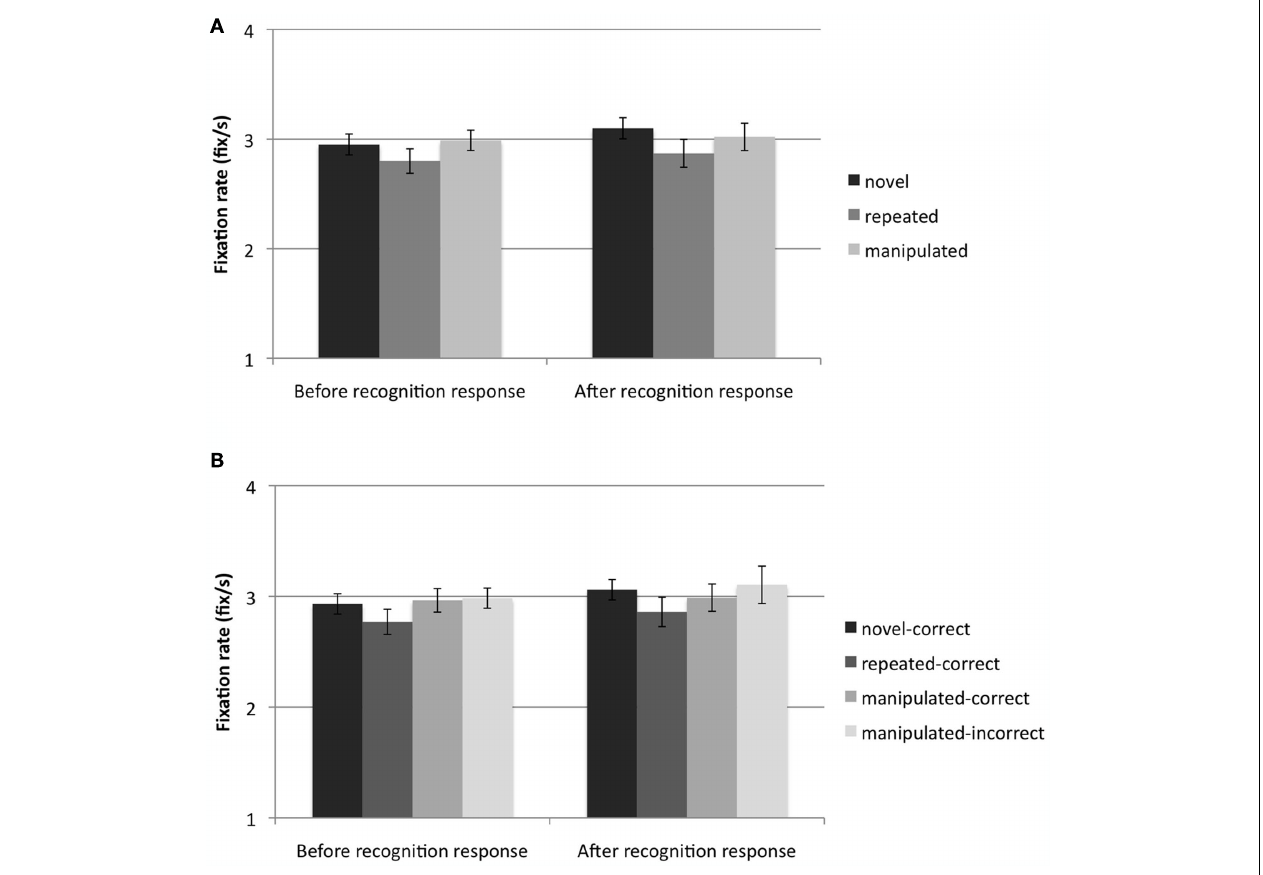
FIGURE 3 | Mean fixation rate (fixations per second) before and after participants’ recognition response across (A) face type: novel, repeated, and manipulated faces; and (B) response type: novel-correct, repeated-correct, manipulated-correct, manipulated-incorrect. Error bars represent SEM.